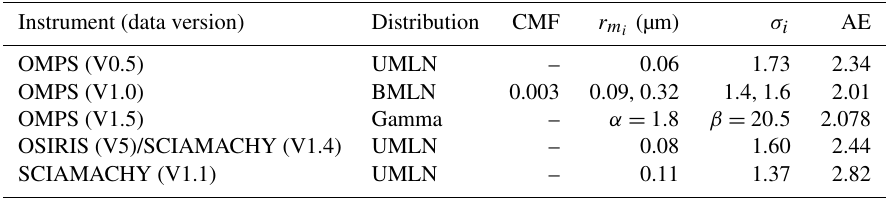
Table 1. Size distribution parameters used to calculate the aerosol phase functions of the various versions of OMPS, OSIRIS v5, and SCIAMACHY. The Ångström exponent (AE) is derived from Eq. (1) using the 525 and 1020nm extinction coefficients. CMF is the coarse mode